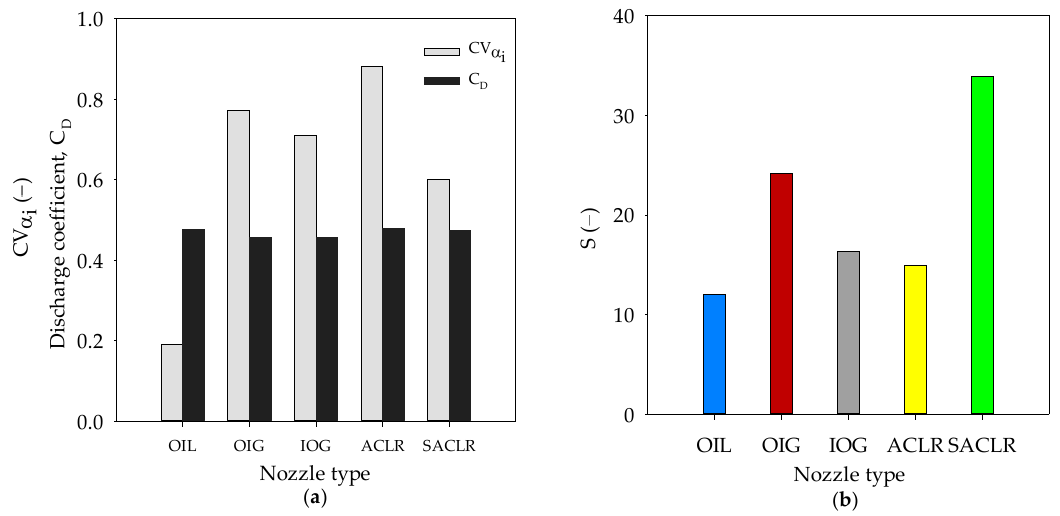
Figure 11. ( a ) Variation coefficient of gas void fraction and C D ; ( b ) slip ratio of the flow inside the exit orifice for the tested nozzles: at GLR = 1.2%, ∆ p mix / p amb = 0.98, µ L / µ G = 55.